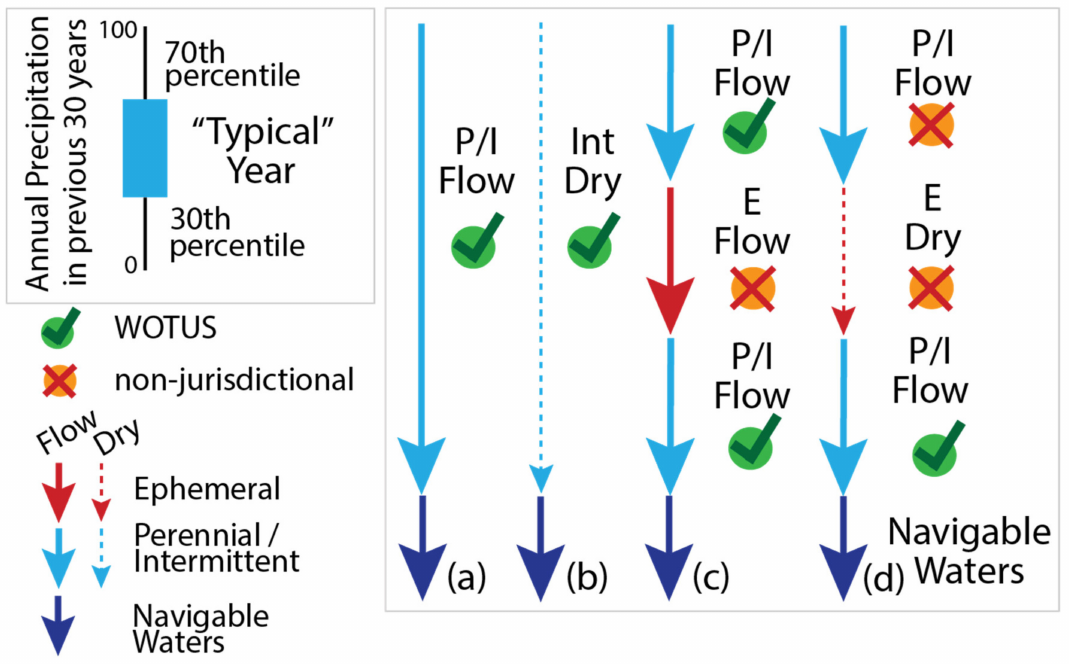
Figure 2. Perennial streams (P) are assumed to always have flow in a typical year and are considered WOTUS (Waters of the United States) if they contribute surface water to navigable waters ( a ). Typical flow is defined as having precipitation that is within the 30th and 70th percentile based on the previous 30 years. Intermittent streams (I) are considered WOTUS if they contribute surface water to navigable waters in a typical year regardless of whether they are flowing ( a ) or dry ( b ). Ephemeral streams (E) are never considered WOTUS ( c , d ). If a perennial or intermittent stream (P/I) is flowing into an ephemeral stream that flows during a typical year, then the perennial or intermittent stream is considered WOTUS ( c ), whereas if a perennial or intermittent (P/I) stream is flowing into an ephemeral stream that is always dry in a typical year, that upstream stream is not considered WOTUS ( d